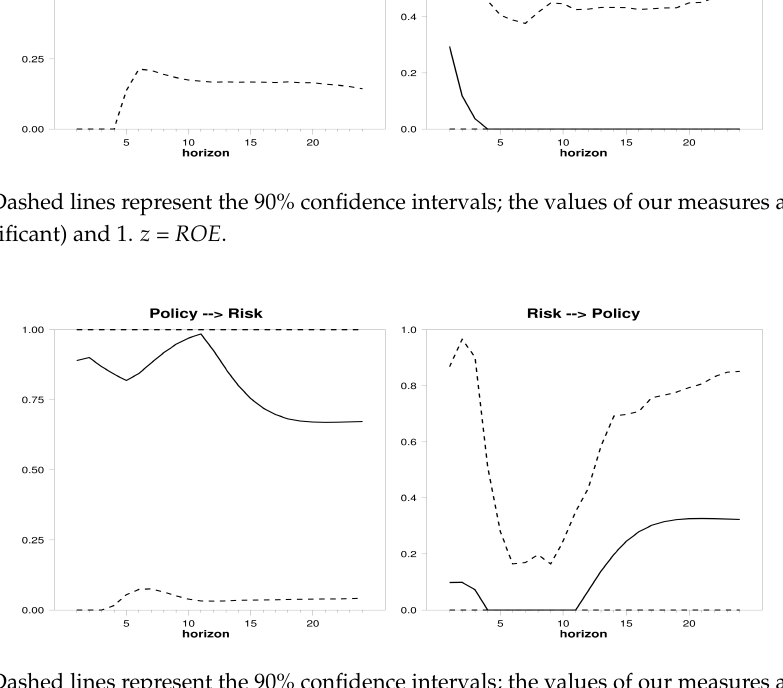
Figure 9. Dashed lines represent the 90% confidence intervals; the values of our measures are between 0 (not significant) and 1. z = LIQ